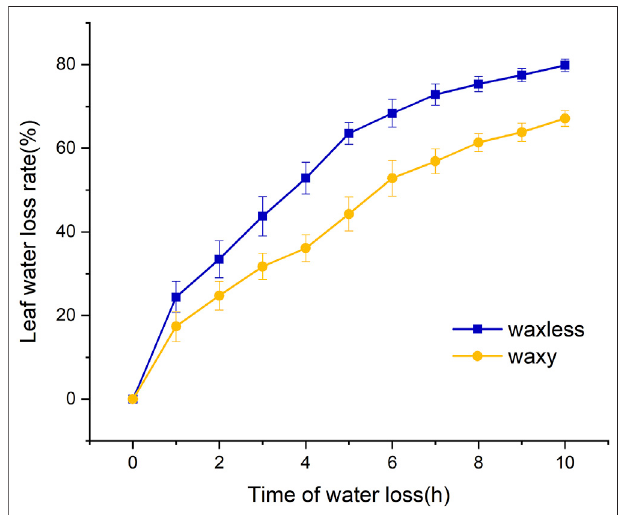
FIGURE2| Waterlossrateof fl agleaves detachedfrommutant waxless and mutant waxy